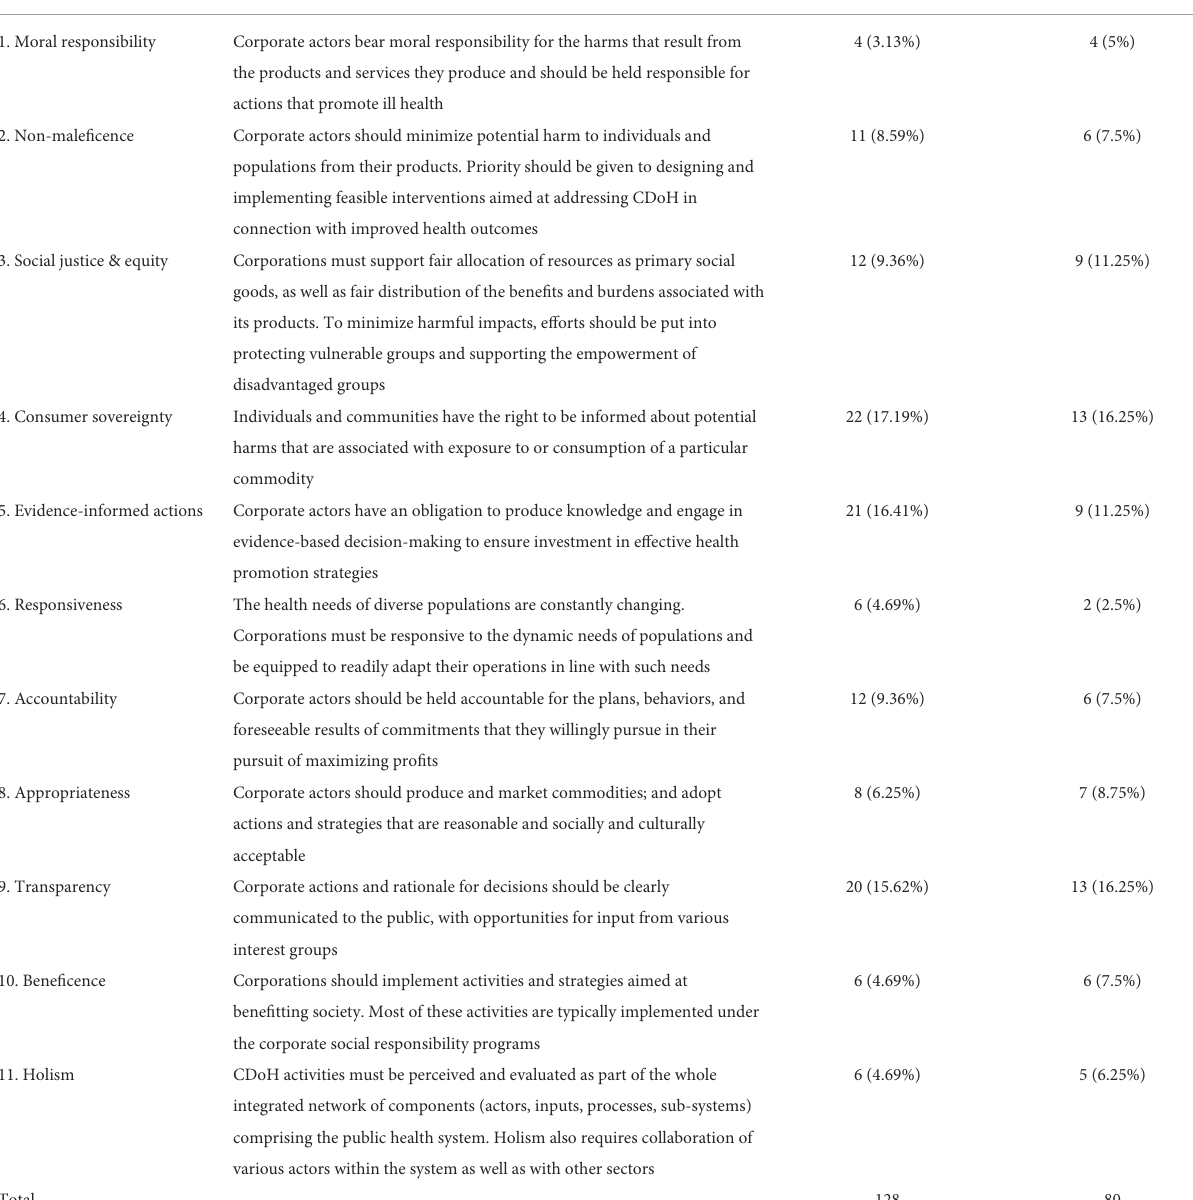
TABLE 1 Ethics framework for commercial determinants of health applied to emails ( N = 16).